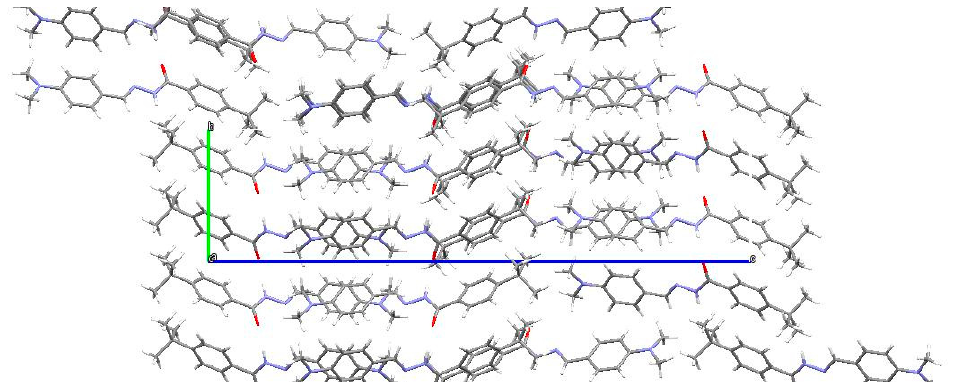
Figure 4. Crystal packing diagram of compound 14. Table 5. Selected bond lengths (Å) and bond angles (°) of compound 14.